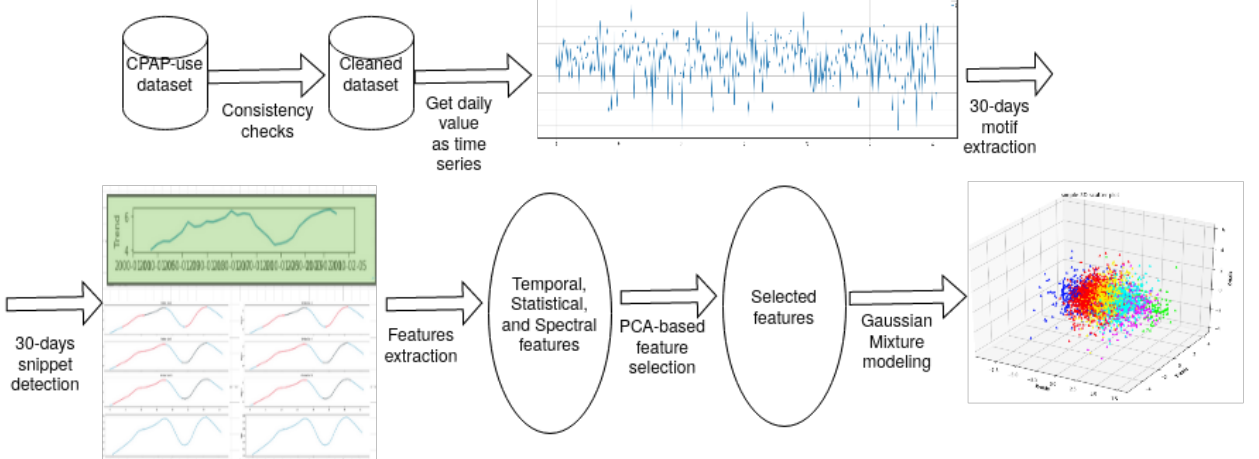
Figure 3. Our methodology to characterize the periods of CPAP use based on analytical techniques over a real-world